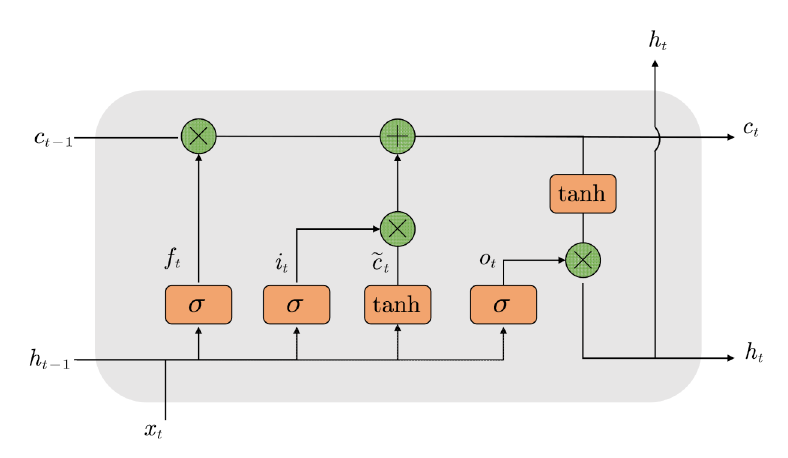
Figure 7. The basic structure of LSTM unit